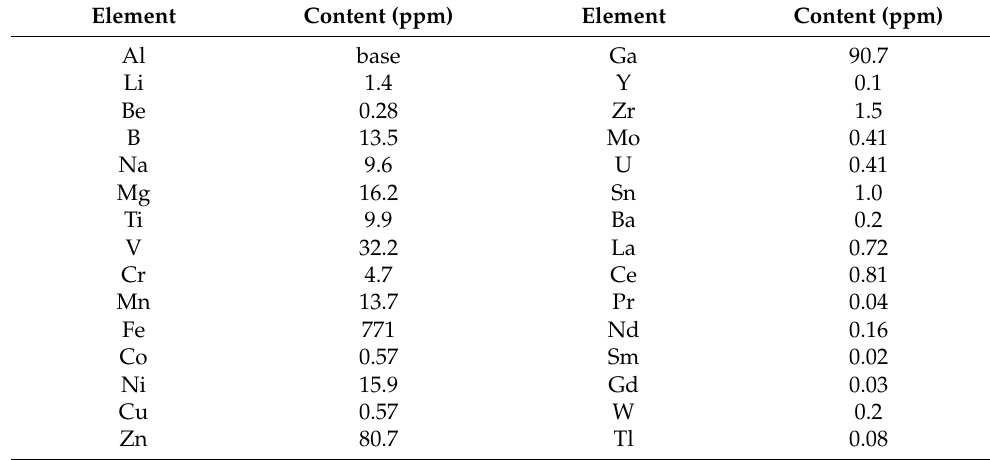
Table 1. Aluminum powder composition.